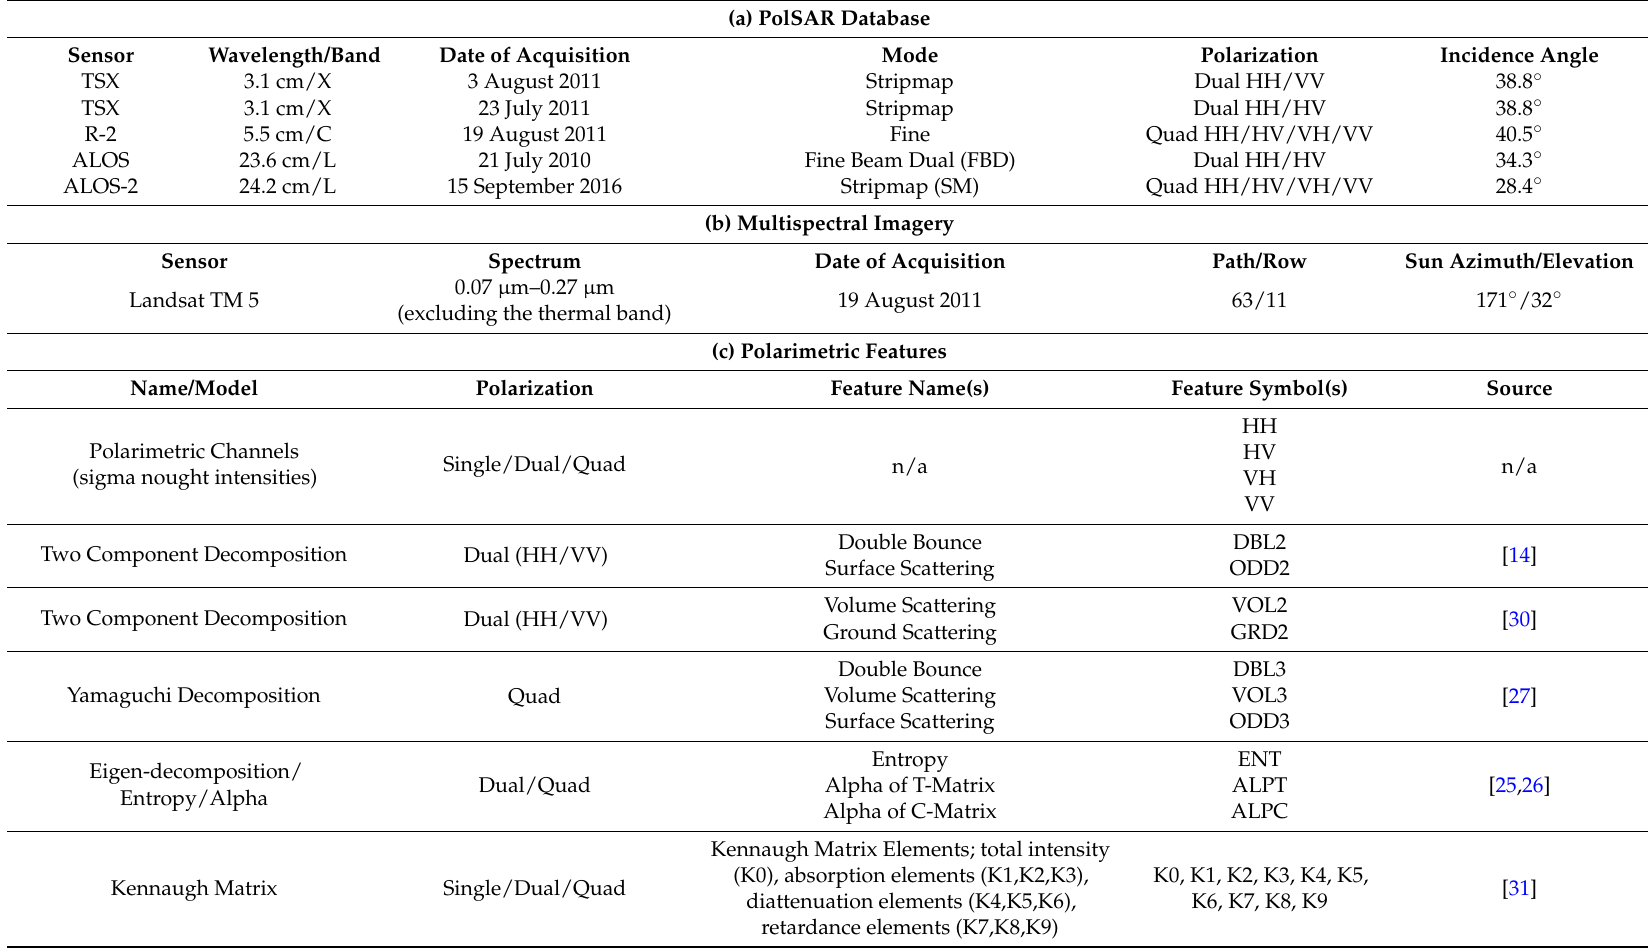
Table 3. ( a ) Acquisition parameters of TerraSAR-X (TSX), Radarsat-2 (R-2), ALOS PALSAR (ALOS), and ALOS-2 PALSAR-2 (ALOS-2); ( b ) acquisition parameters of Landsat TM imagery and ( c ) overview on the polarimetric features considered in the